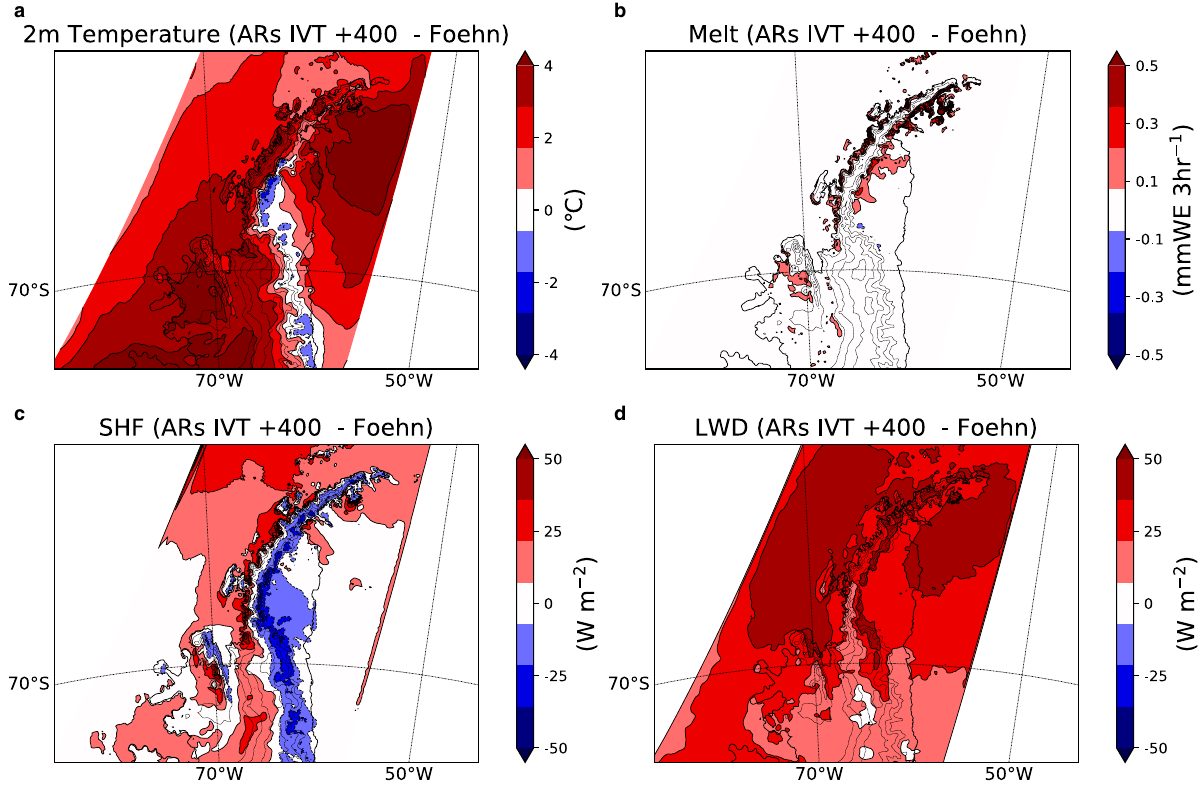
Fig. 7 Differences between standalone ARs and foehn winds. The difference between anomalies associated with AR landfalls with an IVT above 400 kg m − 1 s – 1 and foehn events according to the foehn detection algorithm 11 for MAR a 2 m temperature, b surface melting, c sensible heat fl ux, and d downward longwave radiation from 2009 to